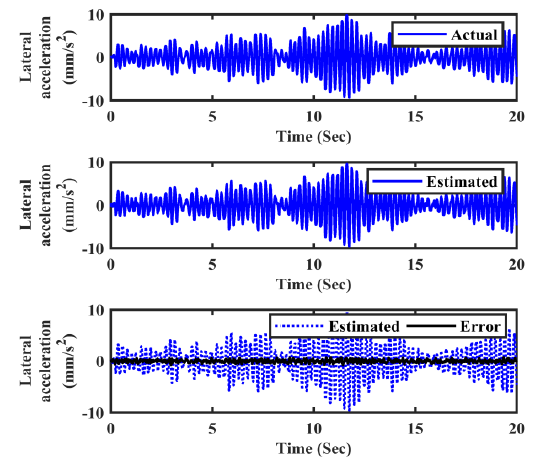
Fig. 9: Lateral Acceleration of Unconstrained Wheelset ( λ ) w = 0.3